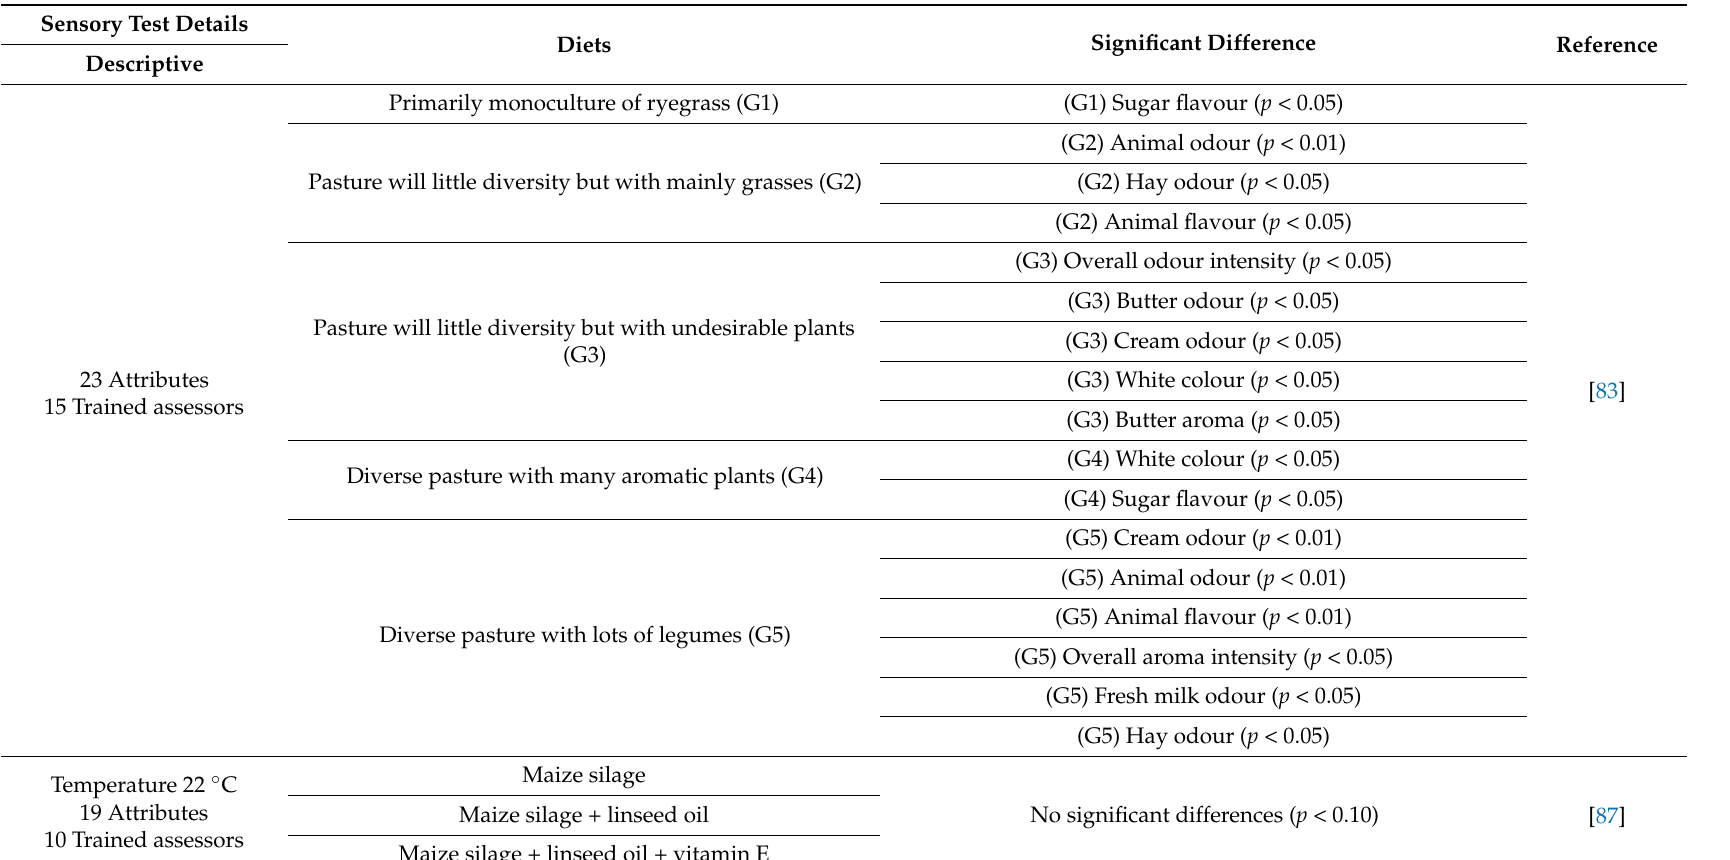
Table 2. Summary of sensory analysis studies of raw bovine